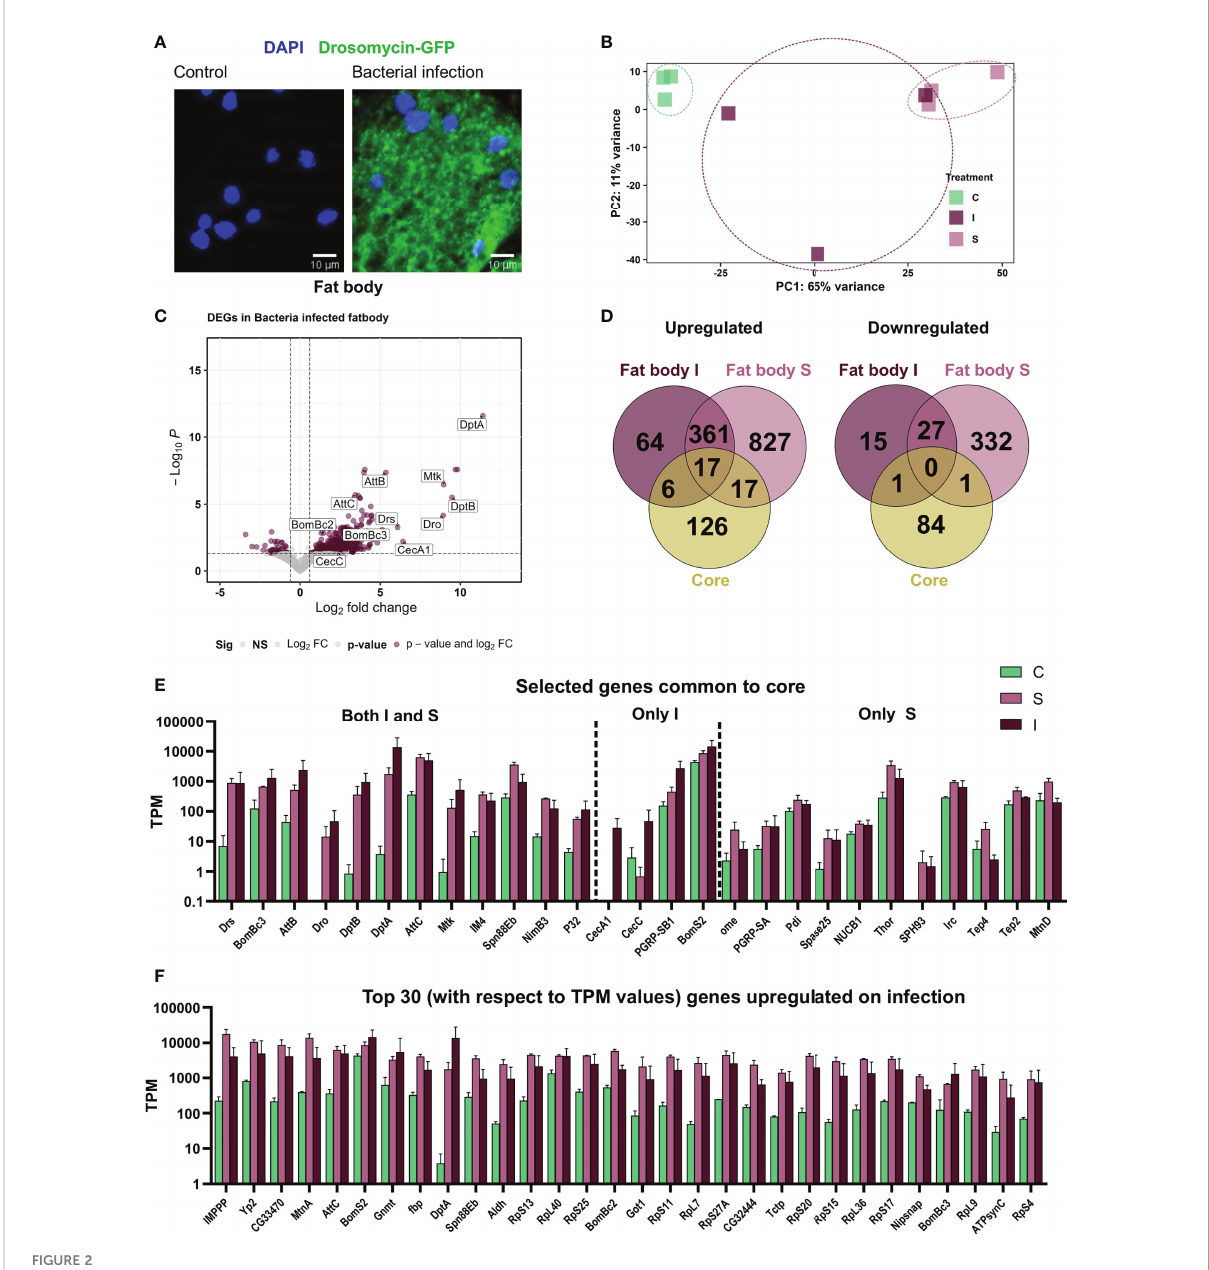
FIGURE 2 Systemic infection with Bacillus subtilis as well as sterile injury exert an immune response in the adult fat body. (A) The fat body from the reporter line Drosomycin-GFP in non-treated controls (left) and after infection with ( B ) subtilis (right). The nuclei are stained with DAPI. (B) Principal Component Analysis plot showing the fi rst two principal components for the RNA-seq analysis of control (C) , sterile injury (S), and bacteria-infected (I) fat bodies. (C) Volcano plot depicting the differentially expressed genes in bacteria-infected fat body cells as compared to untreated control fat bodies. The genes passing the threshold (adjusted p-value < 0.05, log 2 fold change > 0.6) were considered differentially expressed and are marked in maroon and the rest of the genes are marked in gray. (D) Venn diagram analysis of the common number of regulated genes in the bacteria infected (I) and sterile injury (S) fat body data sets and the ‘ core ’ genes from whole body infection experiments are shown separately for the upregulated and downregulated genes. ( E ) Transcript per Million (TPM) values are shown for selected genes that were commonly regulated between the full body ‘ core ’ dataset and the bacteria infected (I) and sterile injury (S) fat body data set. (F) TPM values are shown for the top 30 upregulated genes (in terms of read counts) in bacteria-infected fat